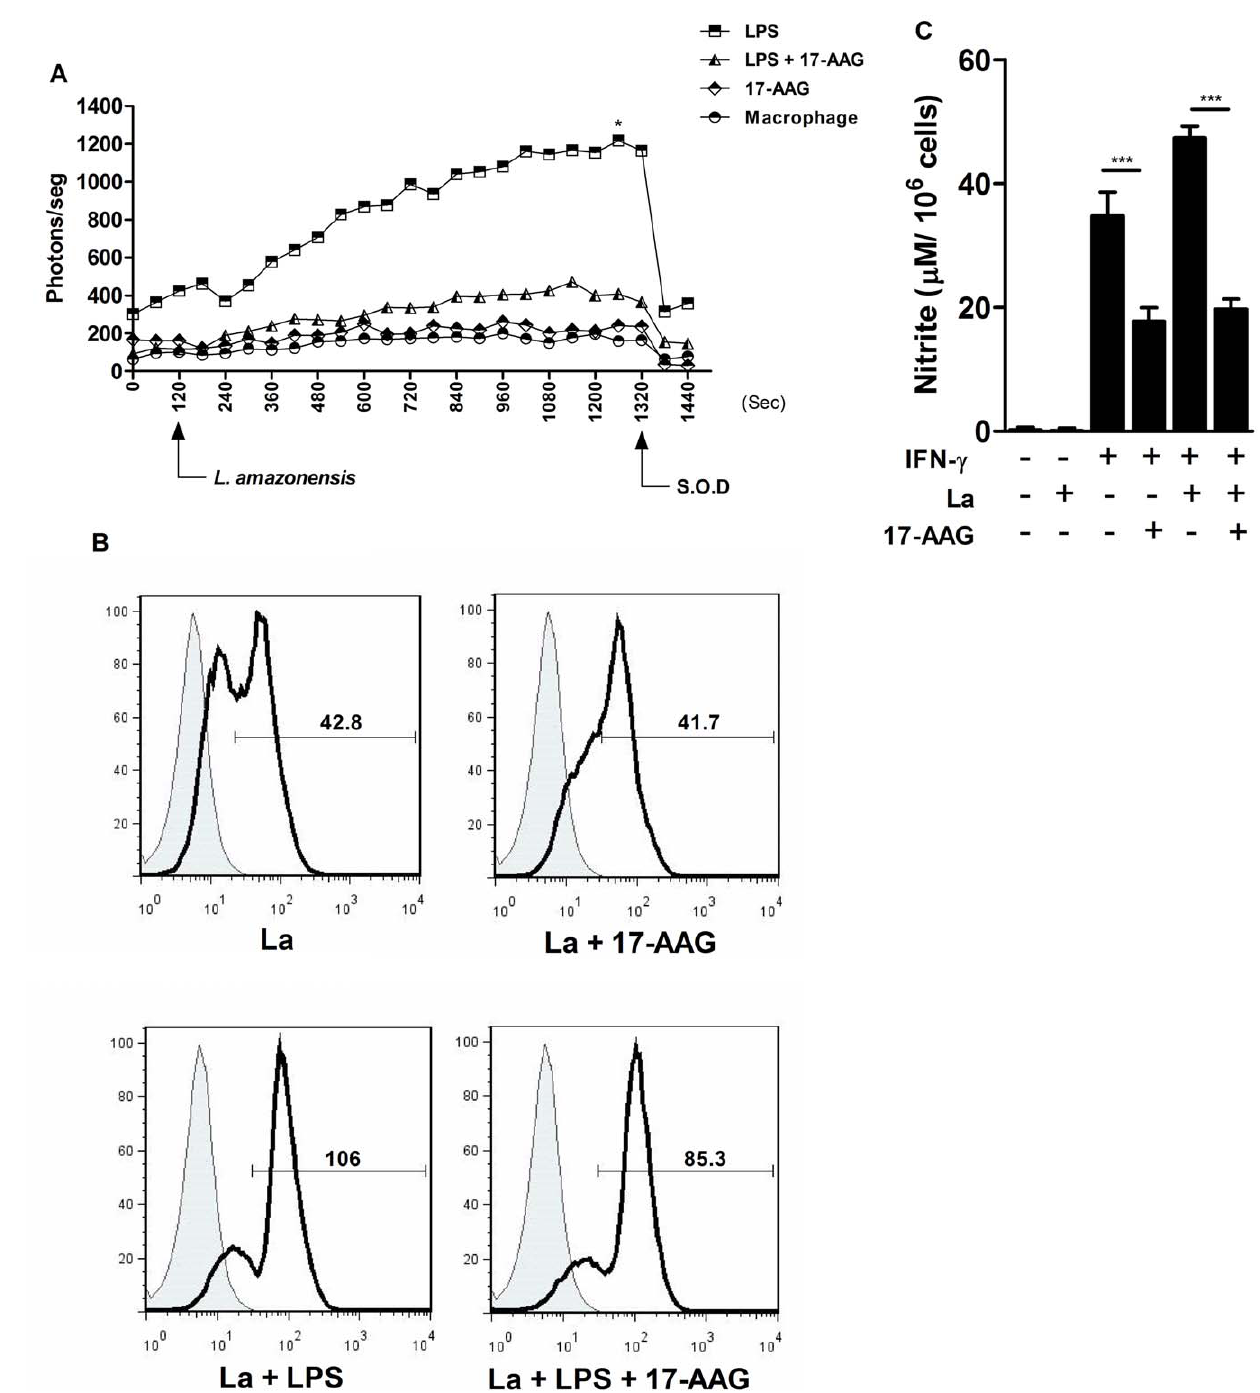
Figure 4. Reduced O 2 2 and NO production in macrophage cultures treated with 17-AAG. ( A ) O 2 2 production was measured at early stages of infection using a lucigenin-derived CL method. Points on the graph represent photon emissions per second by macrophage cultures 2 min prior to the addition of L. amazonensis promastigotes, as well as throughout the incubation period of 20 min. Data are derived from one representative experiment out of four performed in uniplicate (Mann Whitney test, p=0.028); ( B ) Intracellular O 2 2 production was assessed by determining cell fluorescence in the presence of hydroethidine (5 m M) and expressed as MFI using a flow cytometer. The histogram overlay depicts the MFI of hydroethidine-labeled cells (solid lines) in comparison to unlabeled control cells (shaded areas). Data are derived from one representative experiment out of three performed in uniplicate (Mann Whitney test, p =1). ( C ) NO production was measured by detecting nitrite in the supernatants of 17-AAG-treated cells, as described in Materials and Methods. Bars represent NO production measurement expressed as means 6 SD of one representative experiment out of four performed in triplicate or more (Student’s t test, *** p , 0.0001).